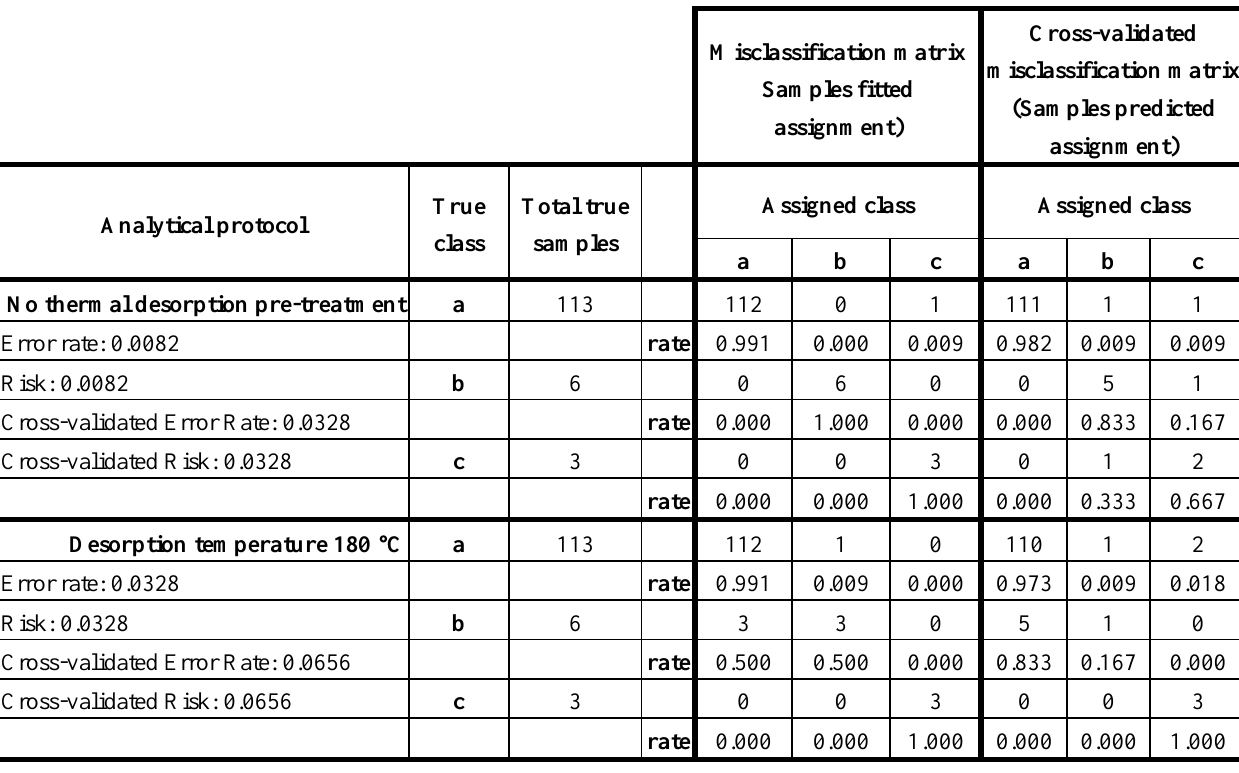
Table 5. Performances of classification by CART for the two enlarged datasets. Class a) , samples non-contaminated; Class b) , samples below the legal limit; Class c) , samples above the legal